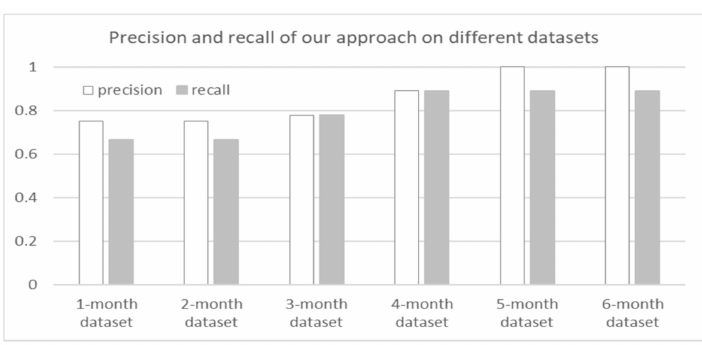
Figure 8. The precision and recall of our approach on different